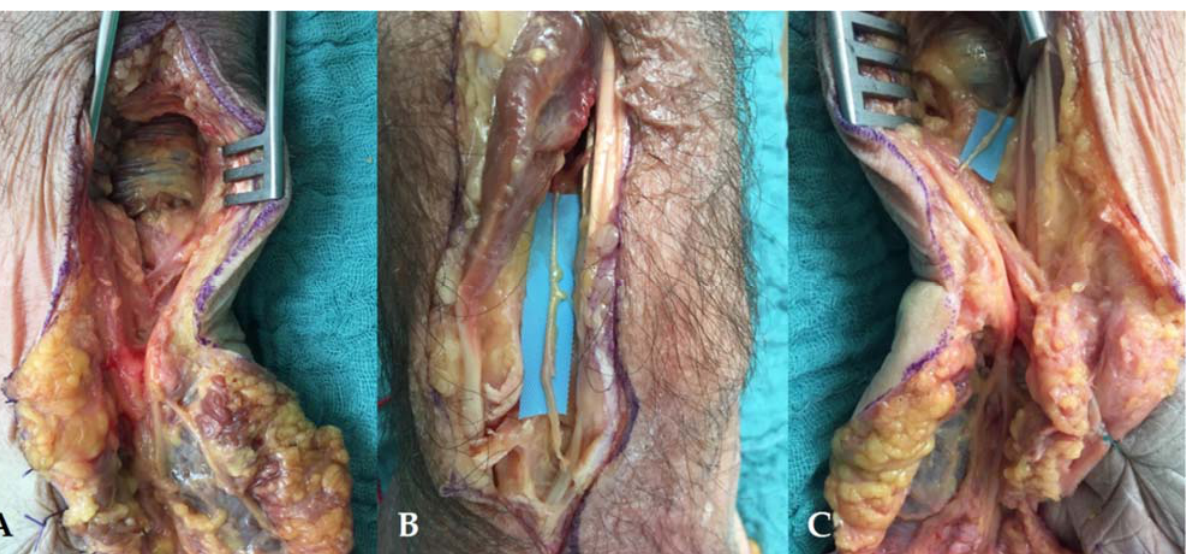
Table 4. BMRC assessment of sensory recovery.